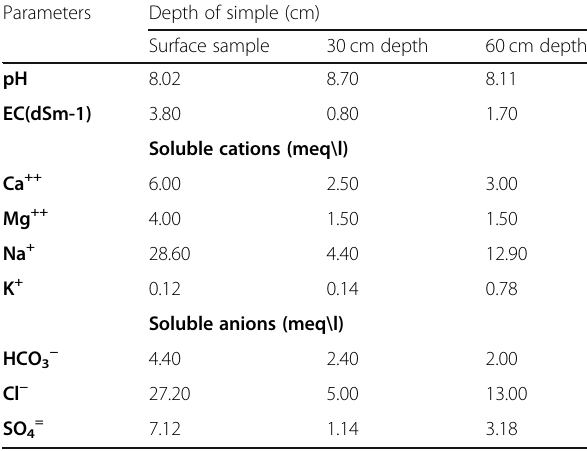
Table 1 Physical and chemical properties of the orchard soil